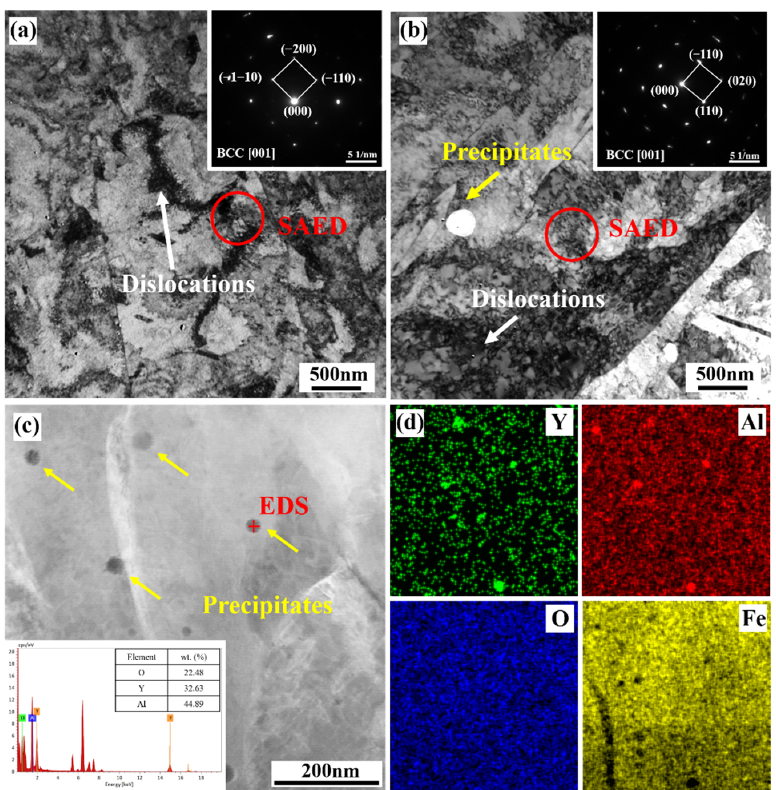
Figure 6. ( a , b ) TEM of heat-treated formed parts without and with yttrium, respectively; ( c ) TEM of the precipitates in yttrium-containing formed parts, with a point EDS analysis; ( d ) EDS mapping of the precipitates in yttrium-containing formed parts.